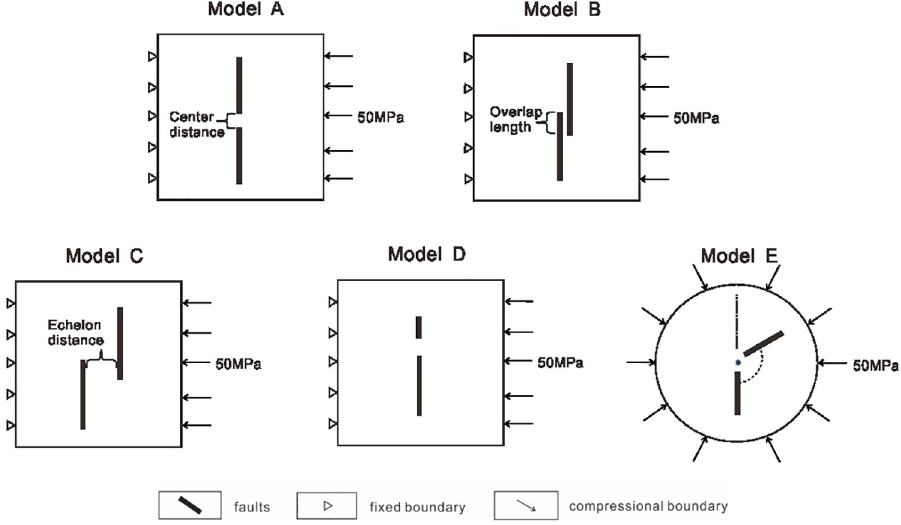
Fig 1. Comparison of model boundary conditions. Model A includes models differing in the center distance. Model B includes models differing in the overlap ratio. Model C includes models differing in the en echelon distance. Model D includes models differing in the length of the upper fault. Model E includes models differing in the fracture opening